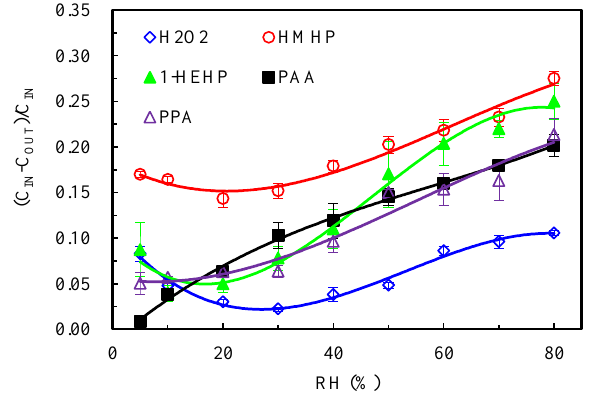
Fig. 2. The variation of peroxides wall losses, (C IN − C OUT ) /C IN , with increasing relative humidity (RH). H 2 O 2 : hydrogen peroxide;